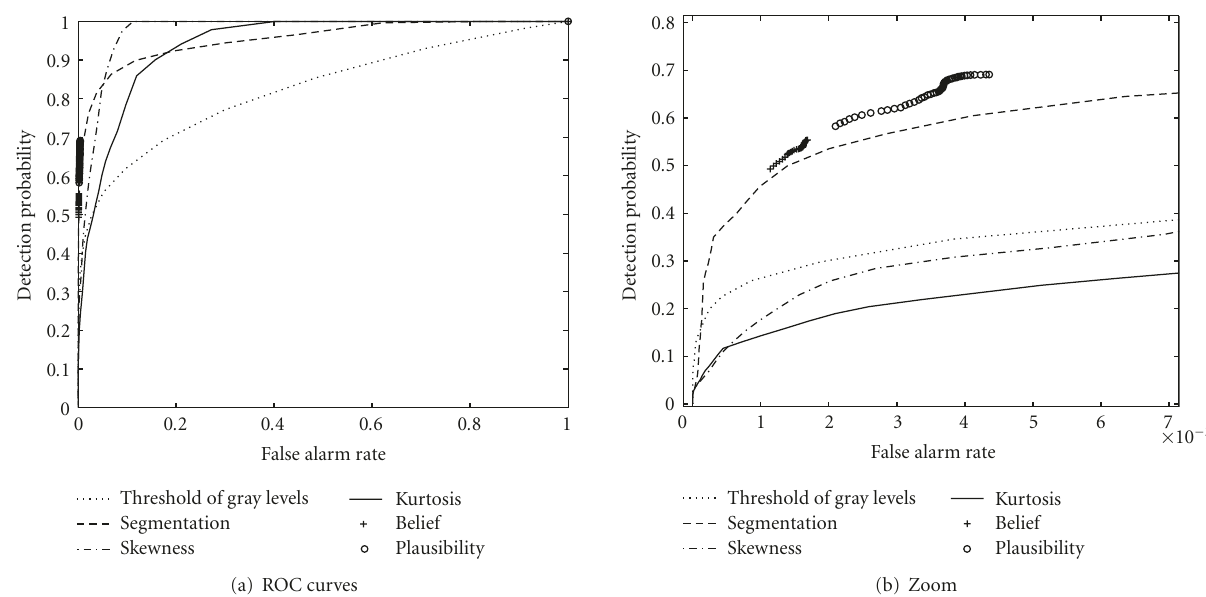
Figure 21: ROC curves of each of the three parameters compared with the results of the fusion process (belief and plausibility) in image 2.